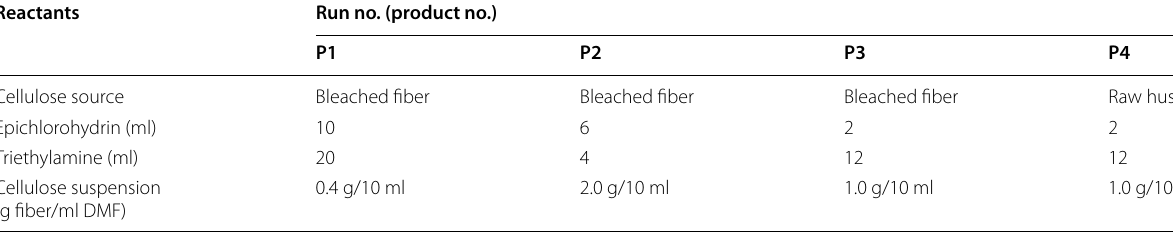
Table 1 The amount of reactants in the preliminary experiments